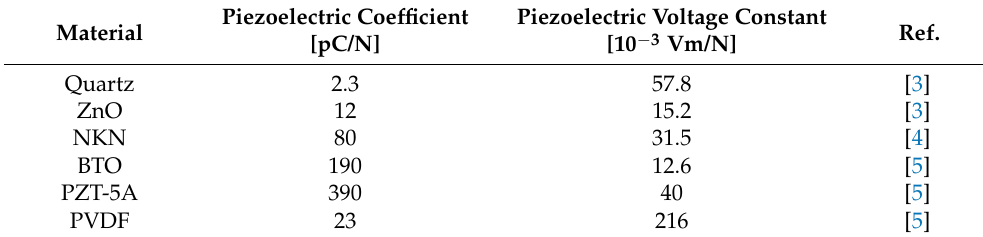
Table 1. Material properties of Piezoelectric